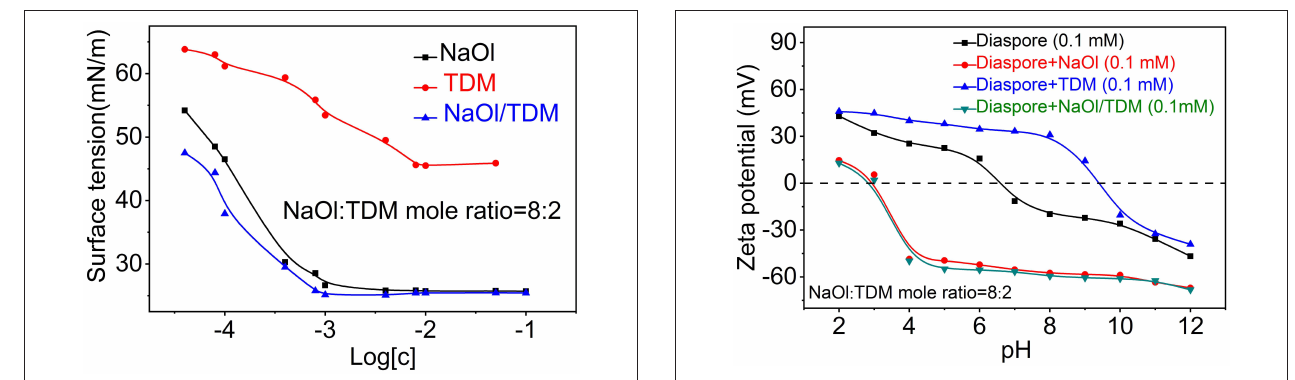
FIGURE 8 | Zeta potentials of diaspore in the presence of various flotation reagents.